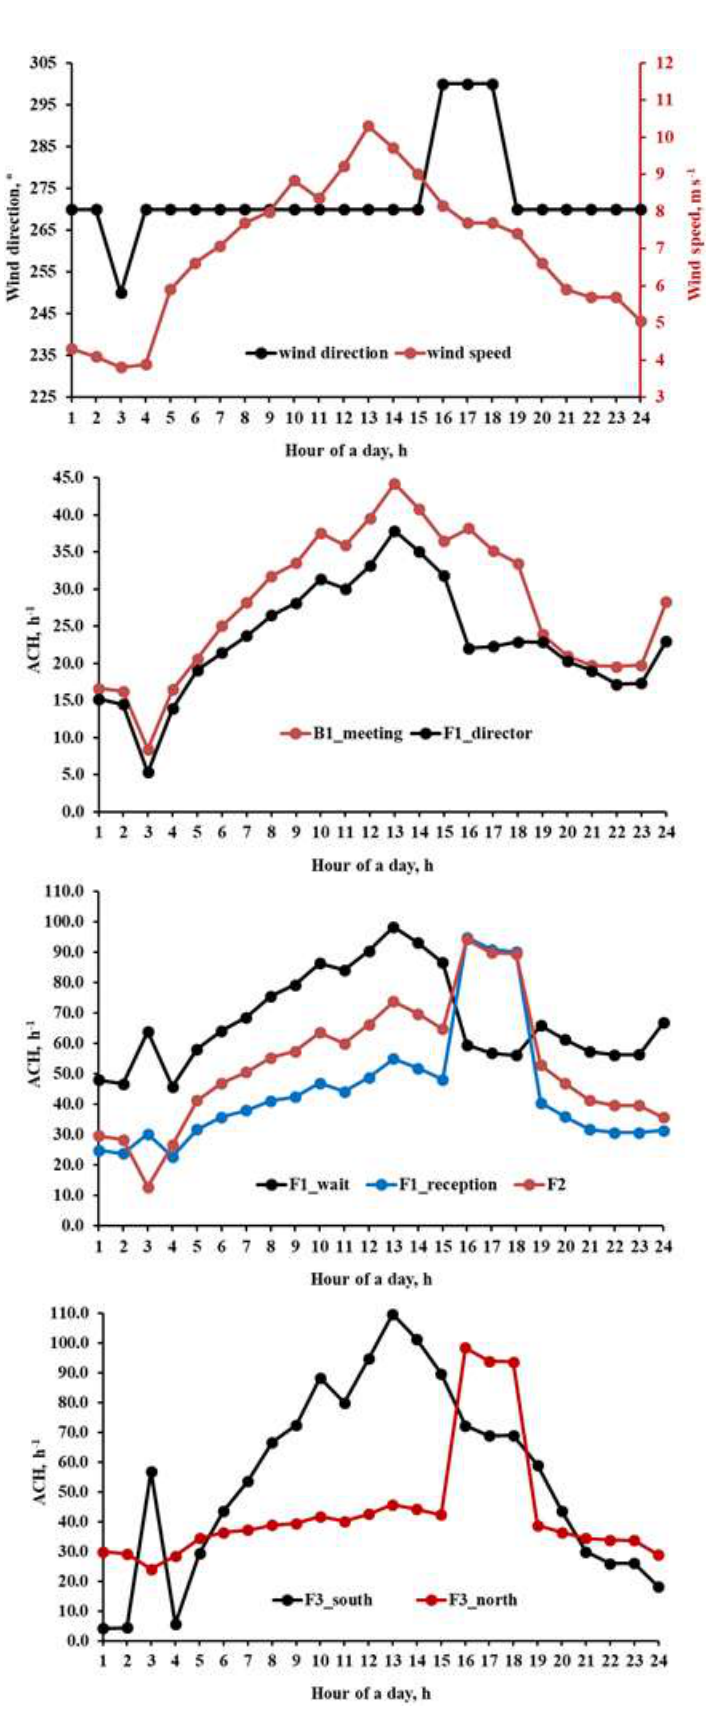
Figure 5. Wind speed, direction, and air exchange rate (ACH) for different rooms for 24 h.